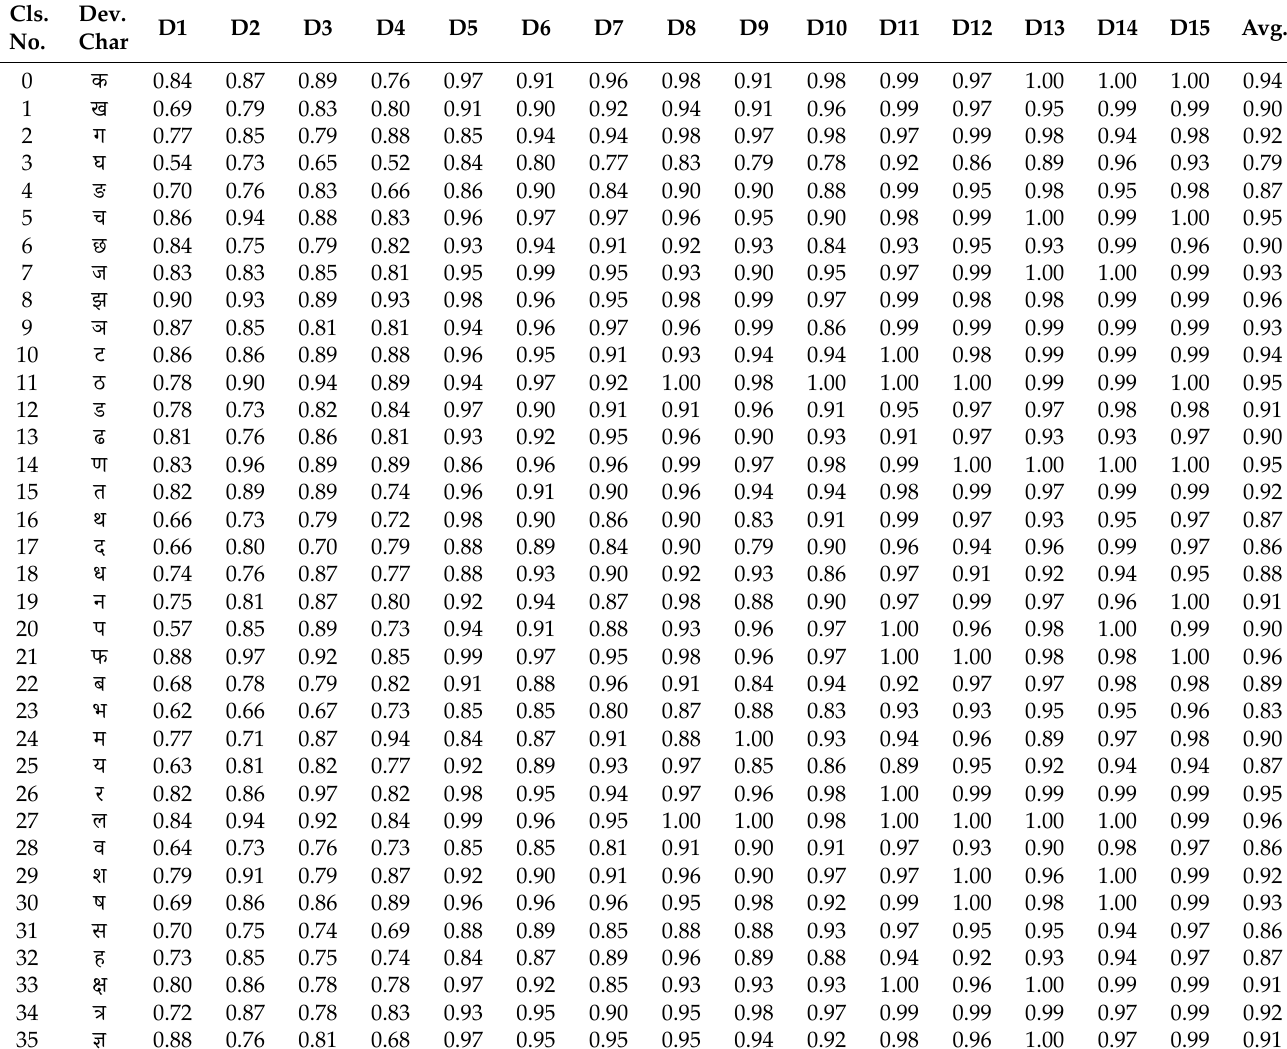
Table 10. Character‑wise precision produced by an SVM classifier for the proposed datasets.